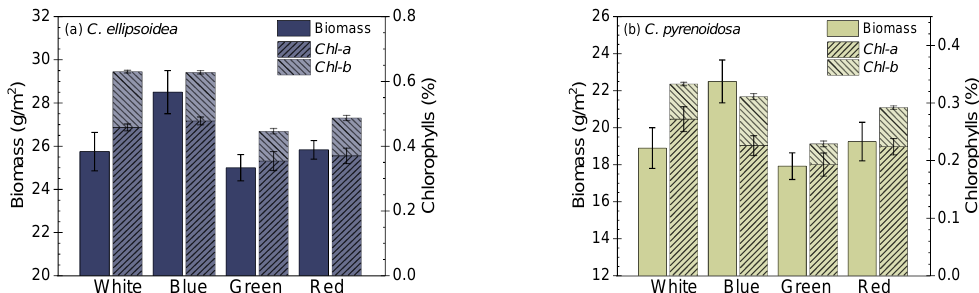
Figure 3. Dry biomass yields and chlorophyll contents (including chl– a and chl– b ) in C. ellipsoidea ( a ) and C. pyrenoidosa ( b ) cultured under different LEDs.